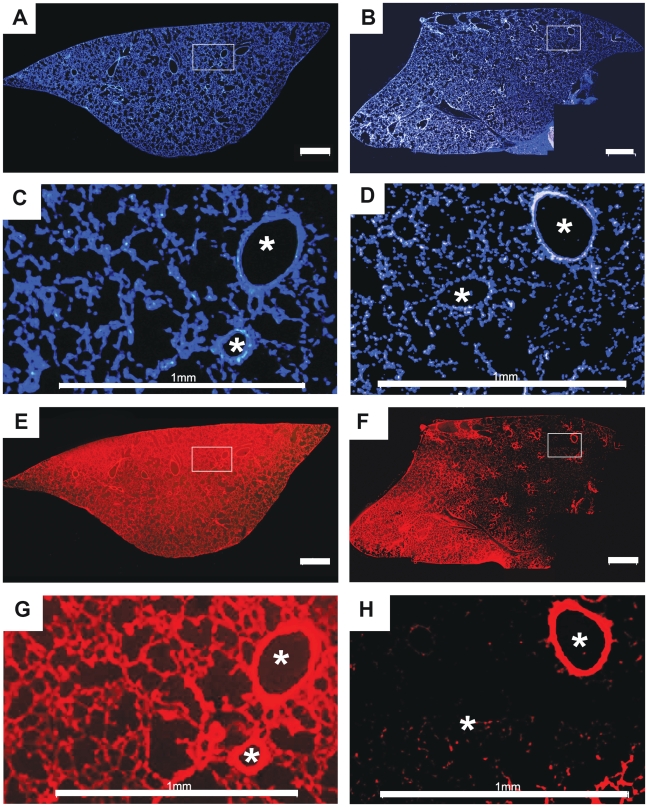
Tiled fluorescent micrographs of coronal cryosections obtained from the left lungs of mice.Mice received either an IV (A, C, E, G) or IT (B, D, F, H) dose of a mixture of Hoe and MTR. A) DAPI channel fluorescence image showing Hoe distribution following IV administration; B) DAPI channel fluorescence image showing Hoe distribution following IT administration; C) High magnification view of the boxed region in A; D) High magnification view of the boxed region in B; E) TRITC channel fluorescence image showing MTR distribution following IV administration; F) TRITC channel fluorescence image showing MTR distribution following IT administration; G) High magnification view of the boxed region in E; H) High magnification view of the boxed region in F. Scale bar = 1 mm. Asterisks mark the cross-sections of the airways, apparent as ellipsoids at high magnification.